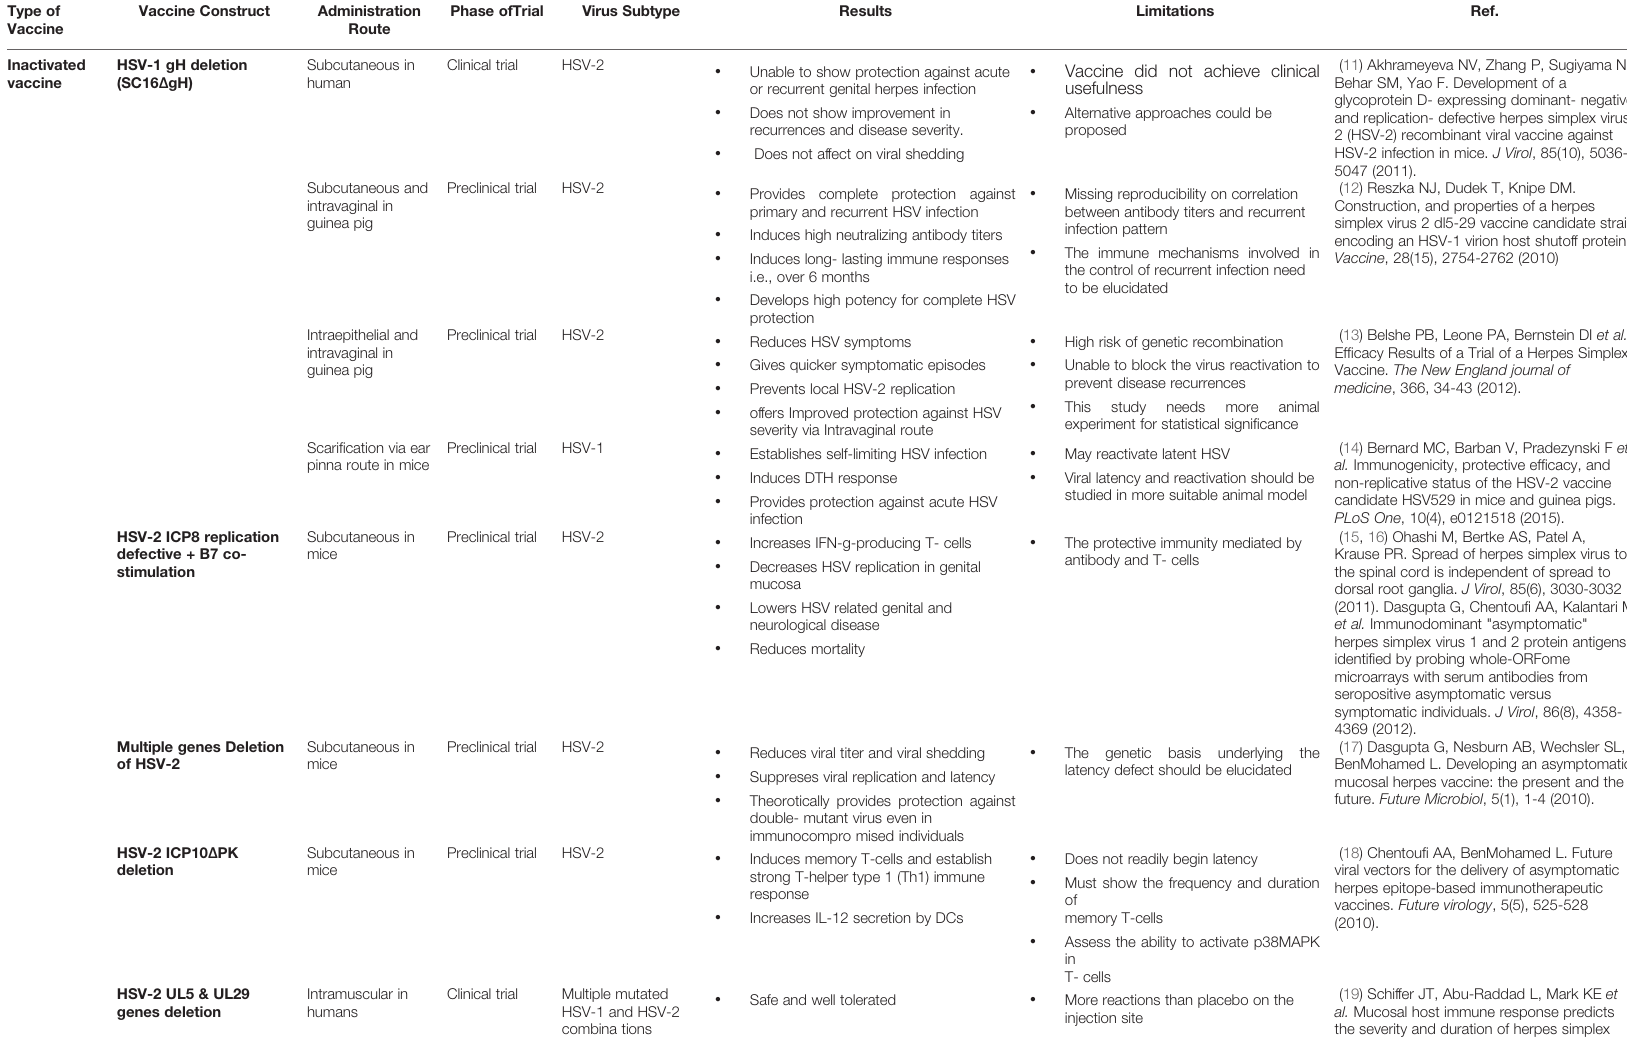
TABLE 1 | Herpes Vaccine Strategies. Type of Vaccine Construct Results Limitations Ref. Vaccine